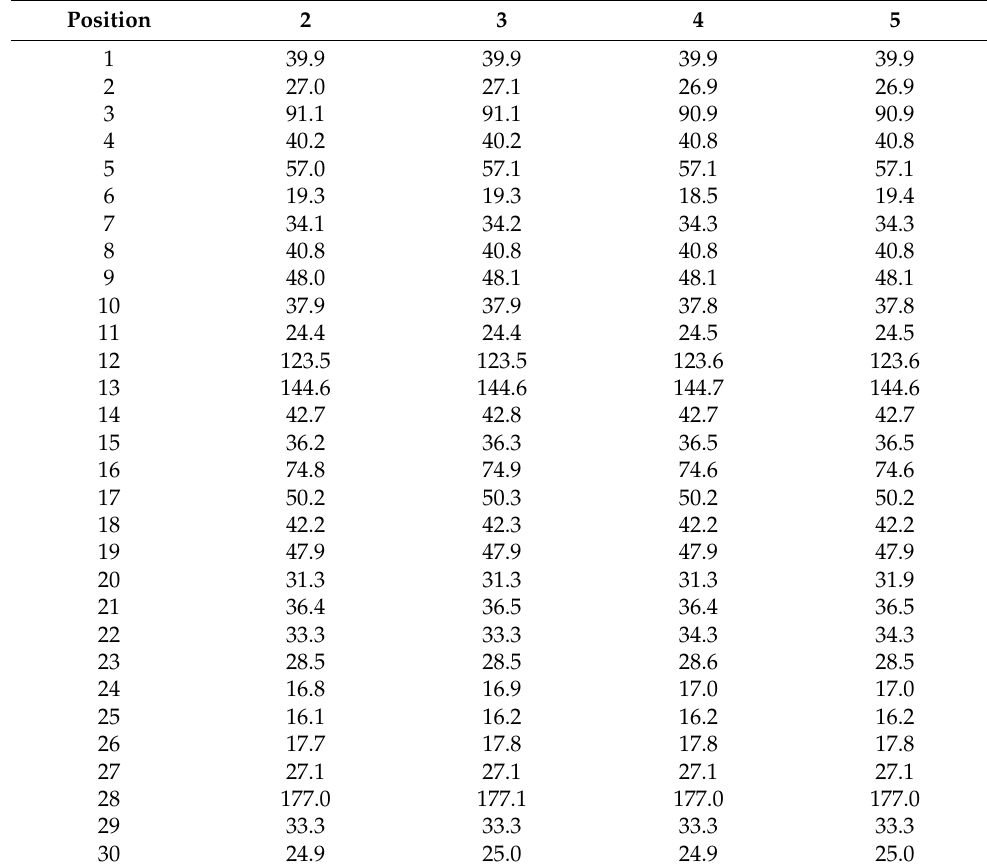
Table 2. 13 C NMR data for the aglycone moieties of 2–5 (125 MHz, CD 3 OD). Position